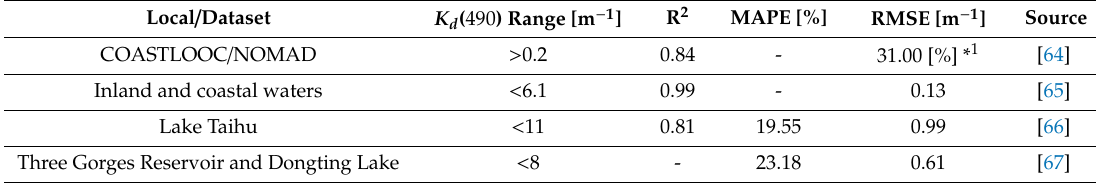
Table 6. Empirical algorithms for K d ( 490 nm ) estimates based on